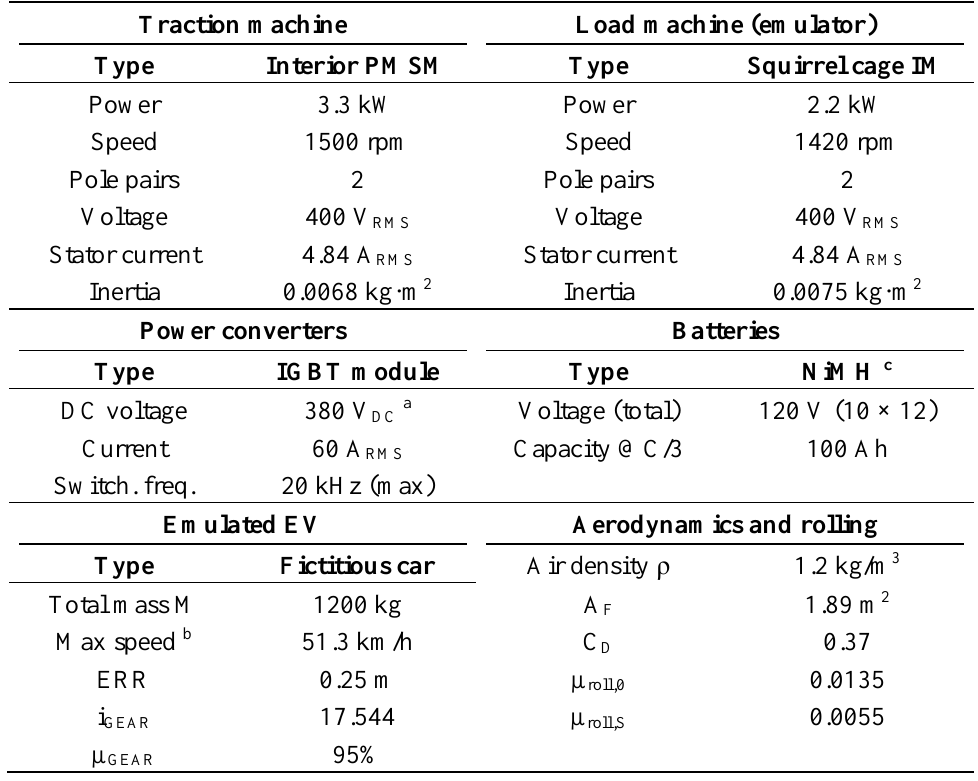
Table 1. Teaching Laboratory Platform: Nominal